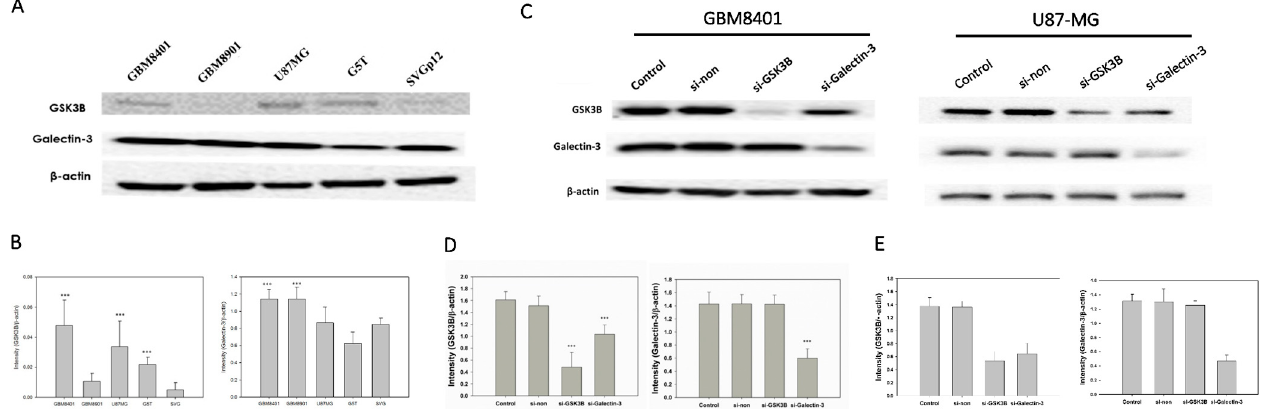
Figure 2. GSK3B and Galectin-3 expression in all GBM cell lines and si-RNA group ( n = 4). ( A )